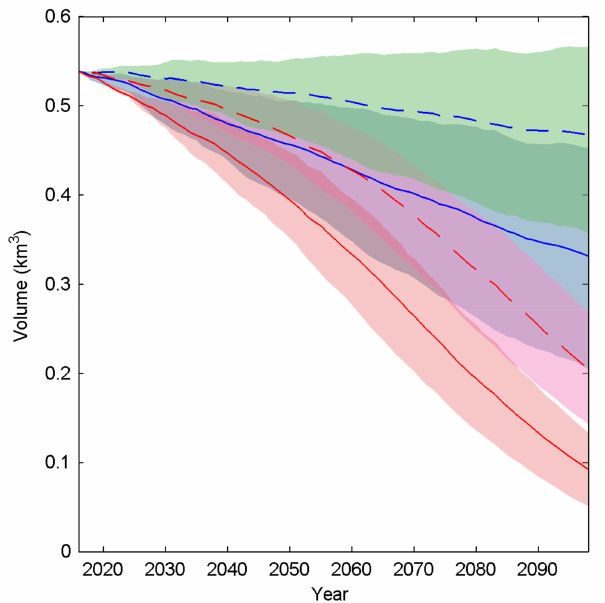
Figure 14. Modeled ensemble mean volume changes from 2016 to 2098 using RegCM4 outputs driven by the 3 ESMs (HadGEM2 − ES, MPI − ESM − MR, and NorESM1 − M) for the period 2017 − 2098 under RCP2.6 (blue) and RCP8.5 (red), with ice dynamics (solid line) and without dynamics (dashed line). The across-model spread with/without ice dynamics are denoted by shading under RCP2.6 (blue/green) and RCP8.5